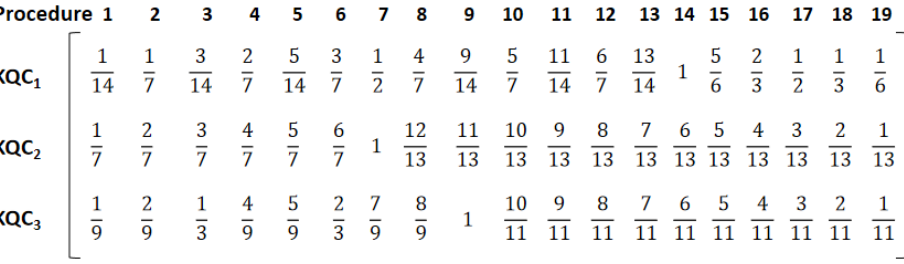
Figure 6. The reachability matrix of key quality characteristics in the procedures. The manufacturing process data and the reachability of each procedure have been obtained. Following the order in Section 3.2 above, the grey correlation analysis matrix of procedure and KQCs is determined by Equation (8). The initial scoring matrix can be ob- tained by dimensionless processing of the data matrix with Equation (10). Finally, the de- gree of grey correlation is calculated through Formula (11), and the critical procedure is determined accordingly. The final results of the example are shown in Table 4 below. The results show that we have identified four critical procedures, which are step 7, step 9, step